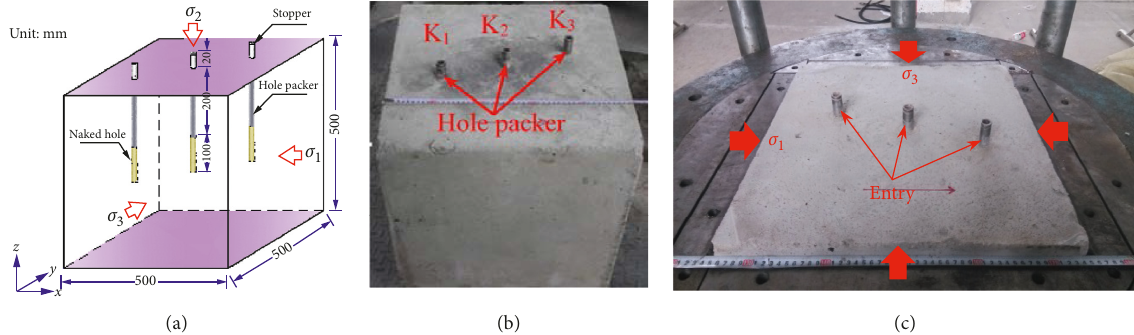
Figure 3: The manufacture of specimens and loading ( σ